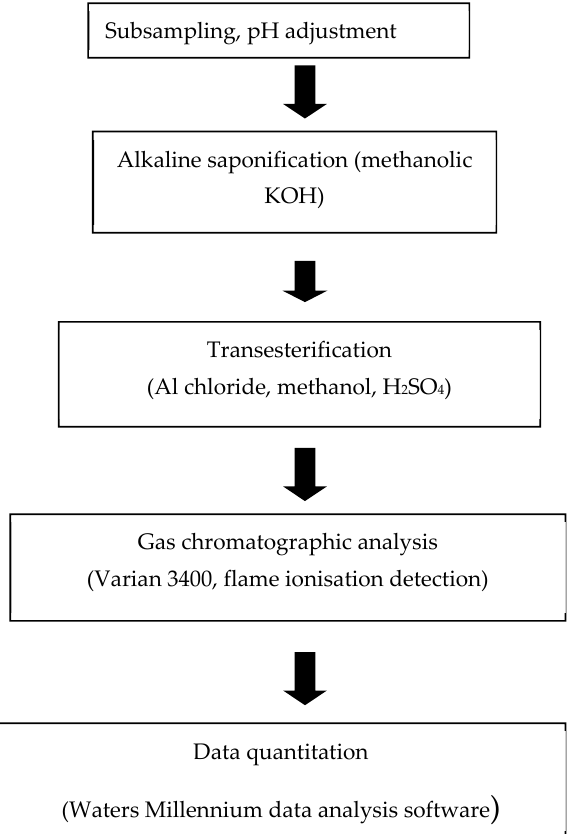
Figure 11. Schematic summary diagram of fatty acid methyl esters (FAMEs) analysis method.